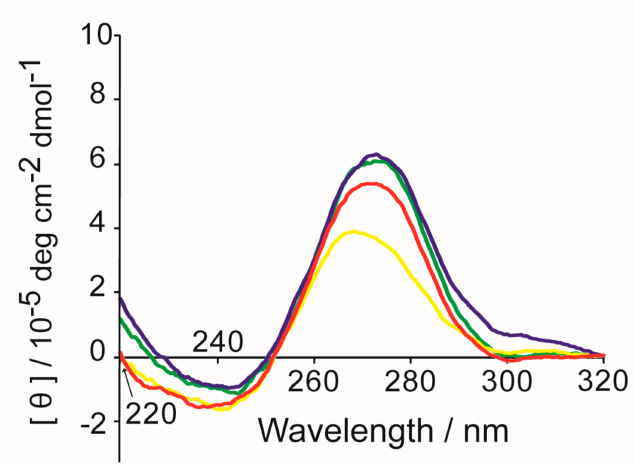
Figure 5. CD spectra of 1 µ M MYC alone (red), 1 µ M MYC and 2 µ M calmyc (yellow), and 1 µ M MYC and 2 µ M dcalmycs (blue: dcalmyc 1 and 2; green: dcalmyc 3 and 4) in a buffer containing 100 mM